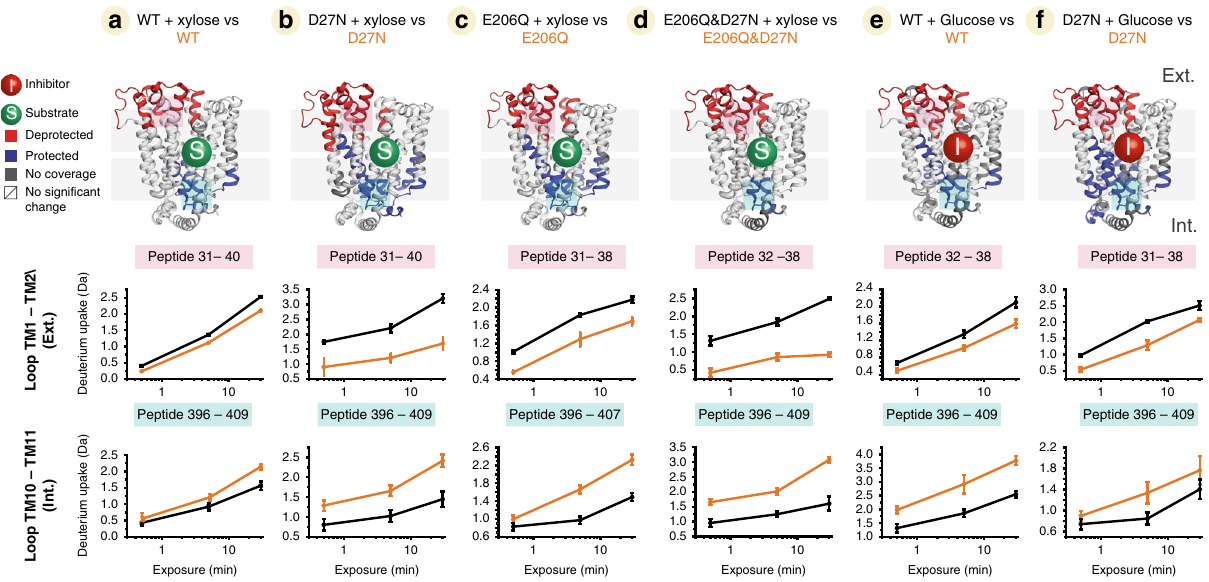
Fig. 3 Conformational change of XylE through substrate/inhibitor binding. a Differential deuterium uptake pattern and peptide deuterium uptake plots (peptide on TM1-TM2 loop and on TM10-TM11 loop) between a WT with substrate (xylose)-bound state and apo state, and b between D27N with substrate (xylose)-bound state and D27N state. c E206Q with substrate (xylose)-bound state and E206Q state, d E206Q&D27N with substrate (xylose)- bound state and E206Q&D27N state and e WT with substrate (xylose)-bound state and apo state. f D27N with inhibitor (glucose)-bound state and D27N state. Figures are plotted onto 3D protein structure (PDB: 4GBY). Blue and red regions indicate negative (protected) or positive (deprotected) deuterium uptake differences between the aforementioned states, respectively. SDs for each time point are plotted as error bars ( n = 3).